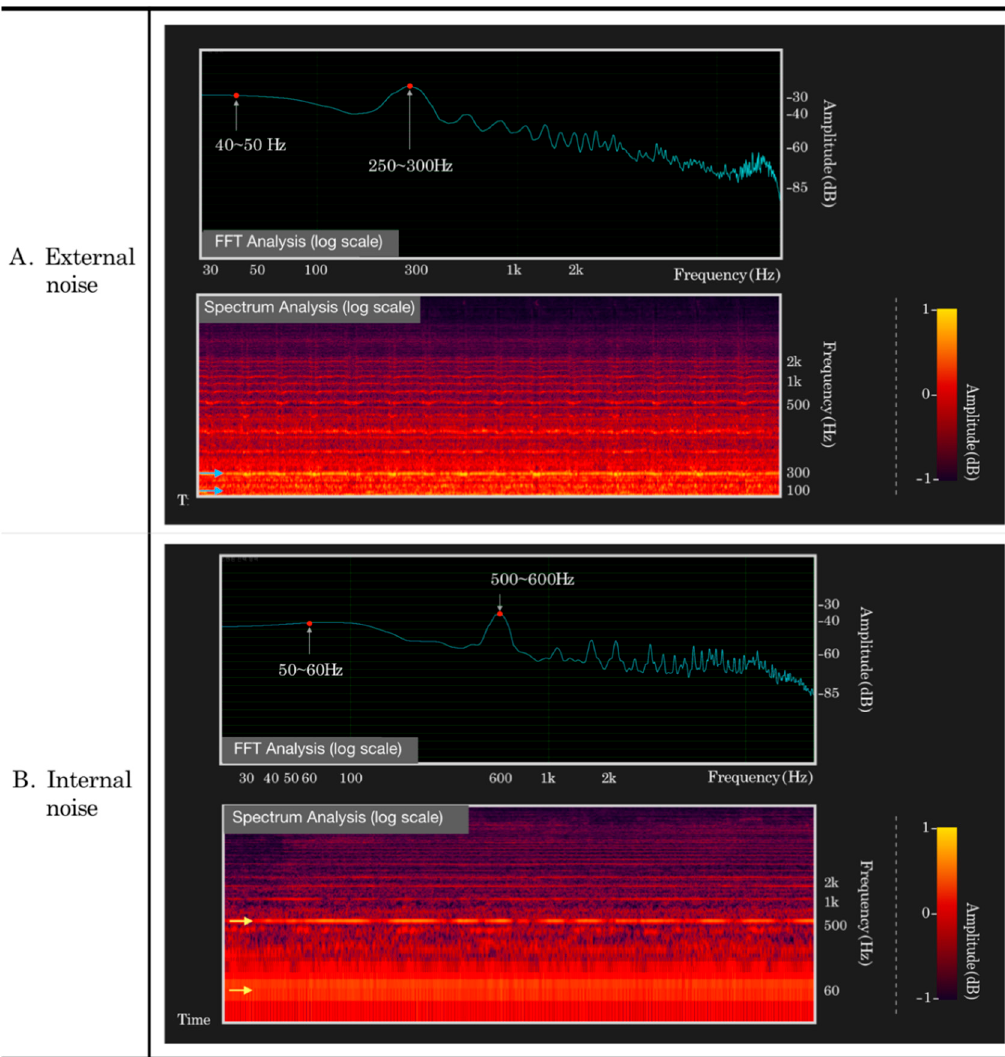
Figure 5. Analysis of noise source at the front of the milling machine. ( A ) external noise; ( B ) internal noise.